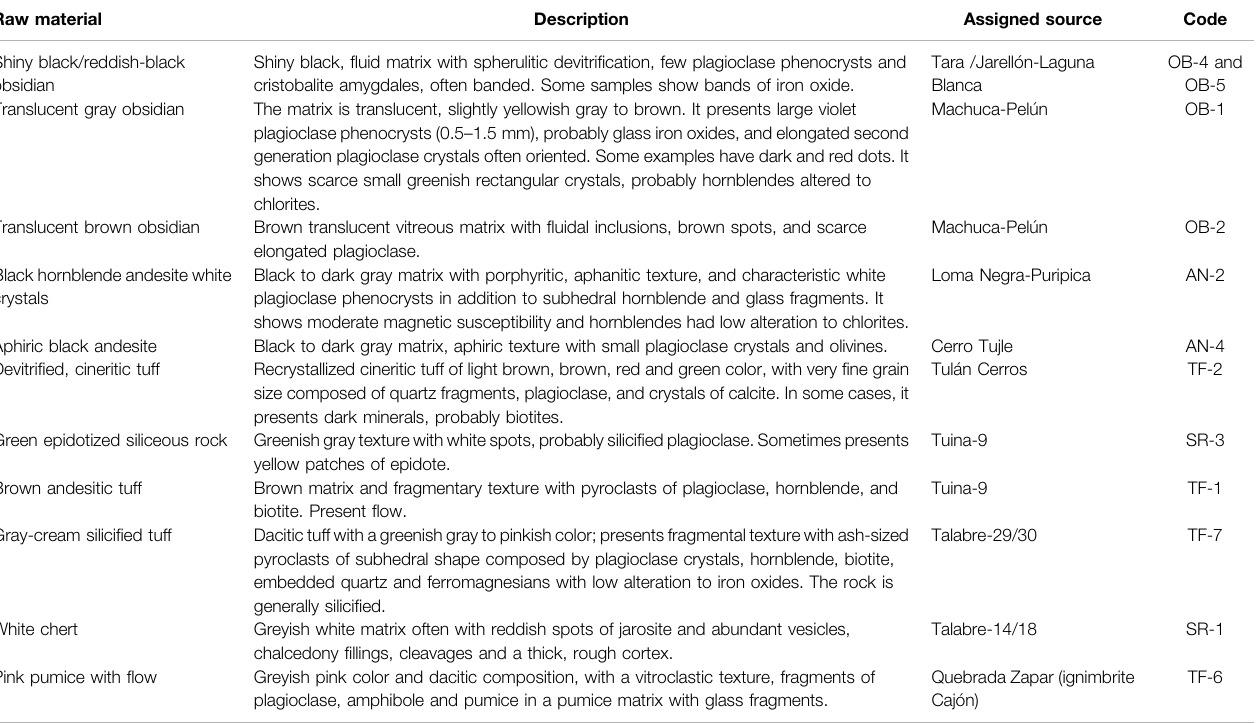
TABLE 4 | Raw materials and assignment to local